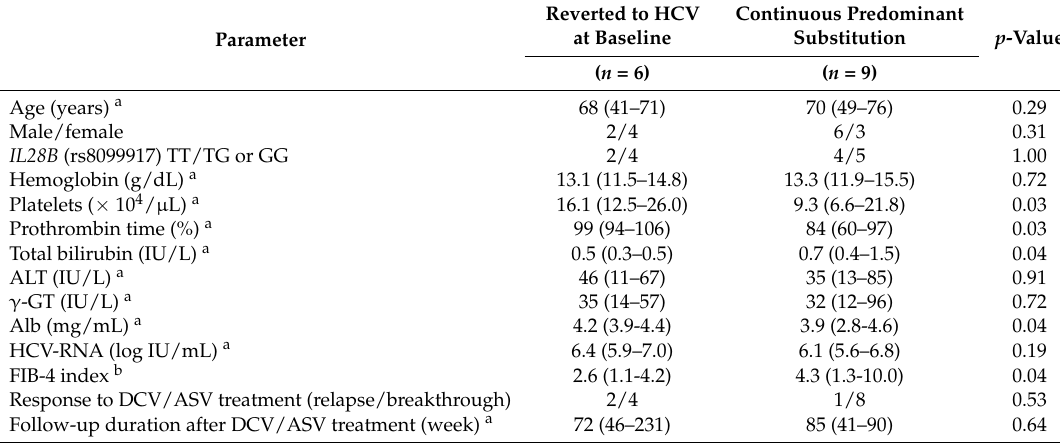
Table 3. Comparison of the two groups stratified by altered predominance in the D168 RAS after DCV/ASV treatment